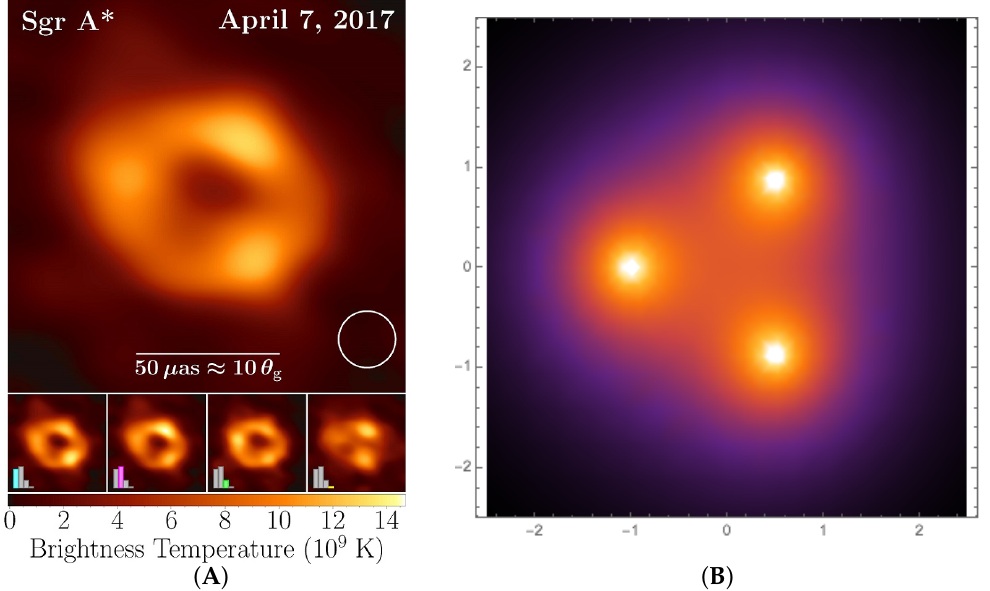
Figure 1. Left panel ( A ): Image of Sgr A* from Ref. [1]. Representative EHT image of Sgr A* from observations on 7 April 2017. This image is an average over different reconstruction methodologies (CLEAN, RML, and Bayesian) and reconstructed morphologies. Color denotes the specific intensity, shown in units of brightness temperature. The inset circle shows the restoring beam used for CLEAN image reconstructions (20 µ as FWHM). The bottom panels show average images within subsets with similar morphologies, with their prevalence indicated by the inset bars. Right panel ( B ): Normalized distribution of temperature-excess in an accretion disk for the model of localized vortices (Section